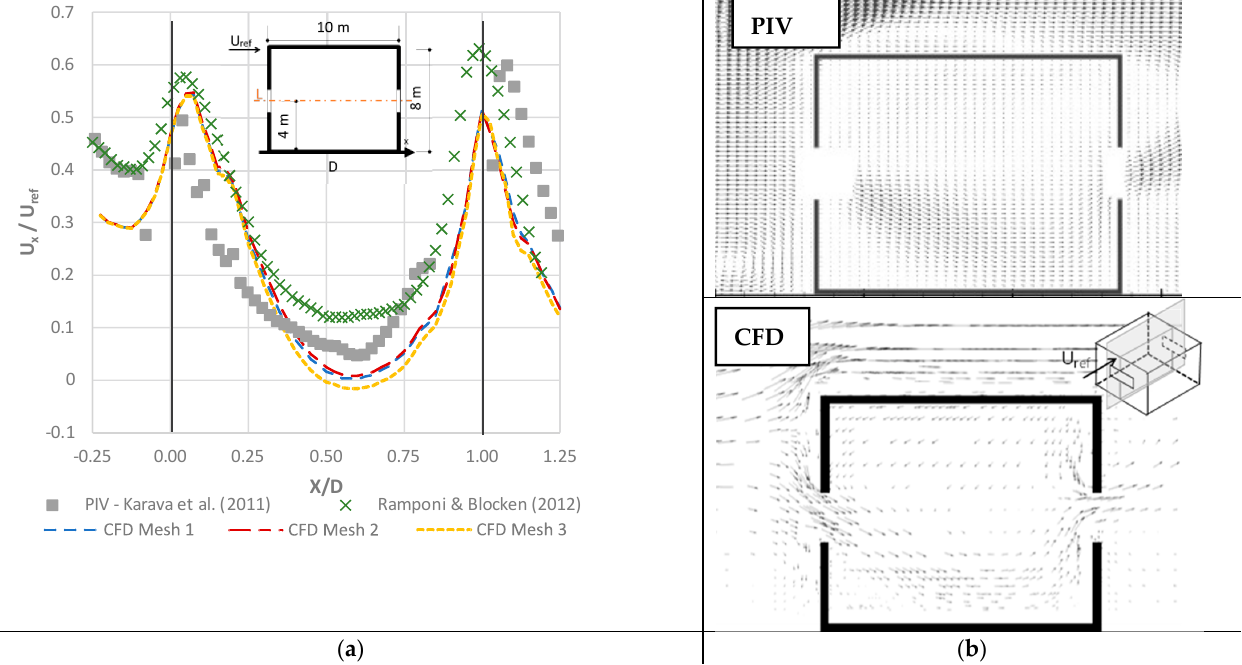
Figure 6. Comparison between the experimental (particle image velocimetry (PIV)) measurements and the numerical CFD results: ( a ) profile of velocity component along the centerline between inlet and outlet openings; ( b ) velocity vector field in the vertical center plane.